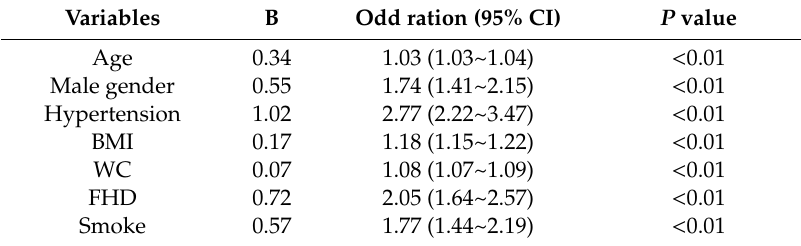
Table 2. Bivariate analysis of the deep learning model (DLM) performance